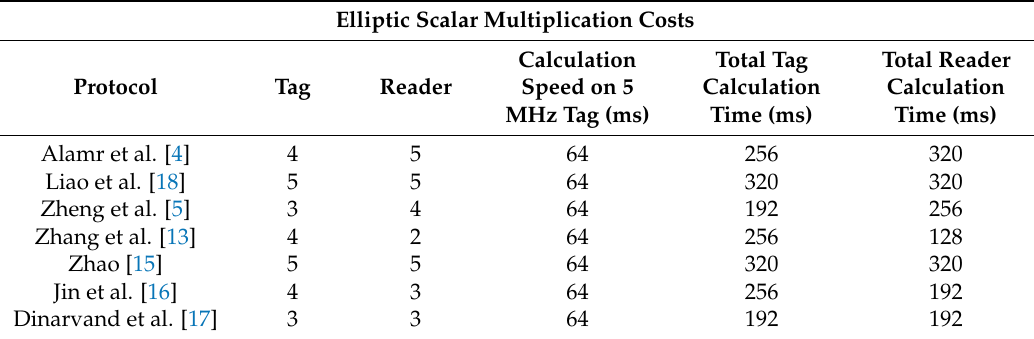
Table 1. Comparison of scalar multiplication costs in each protocol.